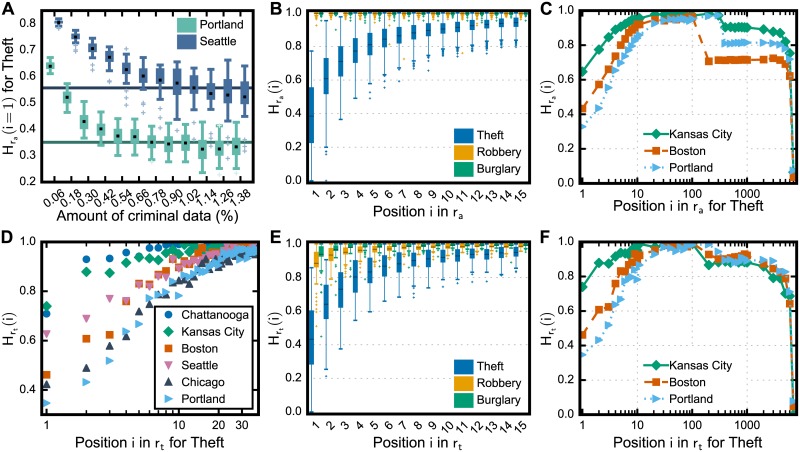
Crime moves across the regions in the cities.Though criminal activities exhibit regularities in their spatial concentration, the relative amount of crime in the regions of the city changes continuously over time. For that, we calculated the Shannon entropy of the positions in the criminal ranks of regions rt and ra which are created using the number of offenses aggregated by time and by the total amount of crime, respectively. In the case of ra, we used data slices of size that (A) minimizes the entropy of the first position of the rank in order to measure (B–C) the entropies of the positions in the rank for all considered U.S. cities. For the time-based rank, weekly data allowed us to measure (D–F) the entropies with respect to time. The overall high entropy in the positions of both ranks indicates that crime is likely to fluctuate across the city, leading to uncertainty about the regions in the rank; still, the most criminal regions have the tendency to be the same ones.